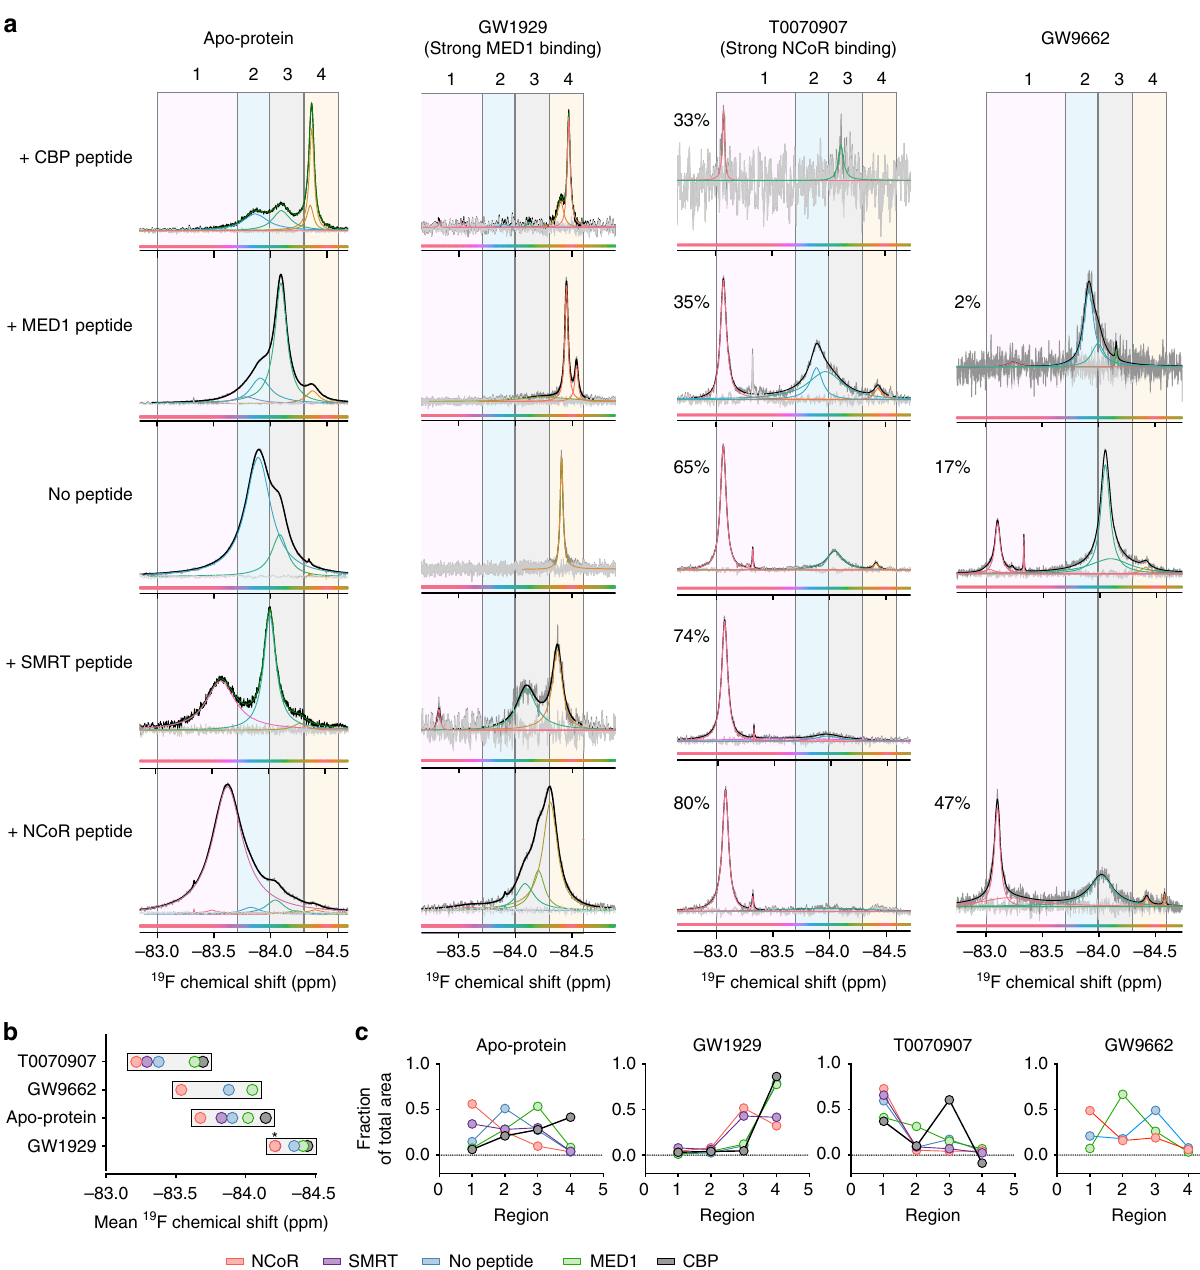
Fig. 7 Co-regulator-binding shifts the helix 12 conformational ensemble. a Deconvoluted 19 F NMR spectra of apo PPAR γ C313A,K502C -BTFA and PPAR γ K502C -BTFA bound to GW1929 or T0070907 in the absence and presence of MED1 coactivator or NCoR corepressor peptides. The percent of total signal area found in the left sharp peak is shown for T0070907 and GW9662 spectra. The small sharp peak at ~ − 83.3 ppm is free BTFA. b Mean-weighted chemical shift values from the plots in a . c Fraction of the total peak areas in the four colored boxed regions in a , which roughly correspond to the clustered spectral regions from Fig. 2; with the two middle regions corresponding to the two peaks observed for apoprotein. Agonist-bound PPAR γ is changed little by MED1 binding, whereas NCoR binding changes the spectrum drastically and vice versa for inverse-agonist (T0070907)-bound PPAR γ . *SMRT-induced mean chemical shift in GW1929-bound PPAR γ K502C -BTFA is the same as NCoR. These experiments were performed